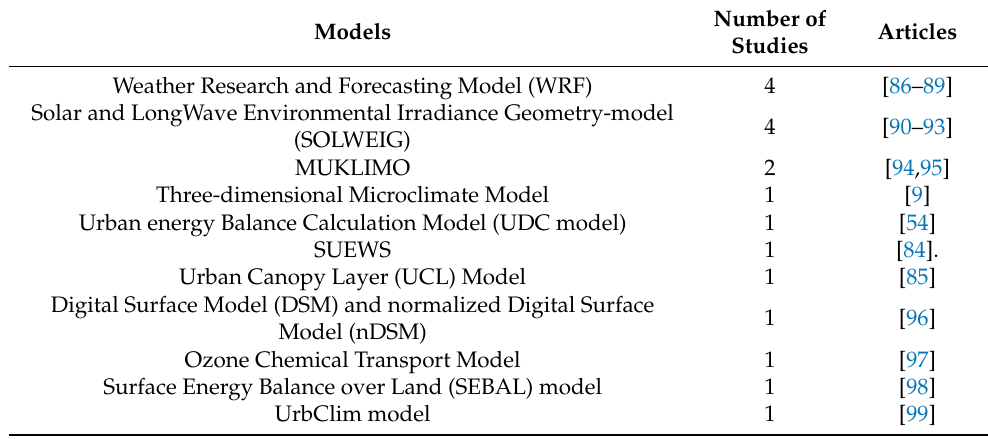
Table 6. Models frequently used in LCZ